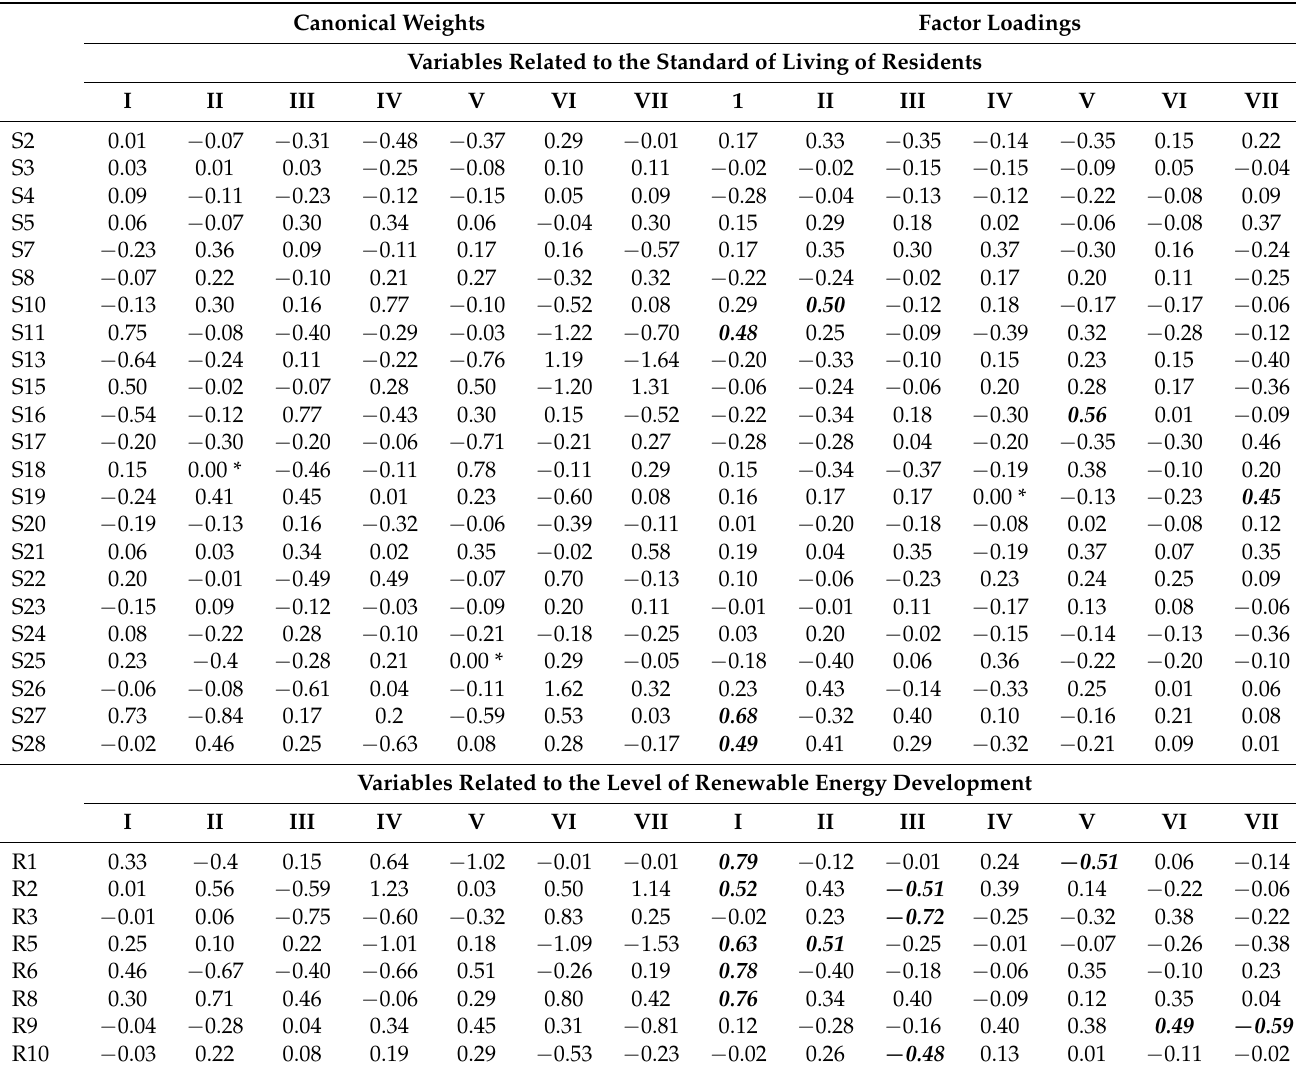
Table 6. Canonical weights and factor